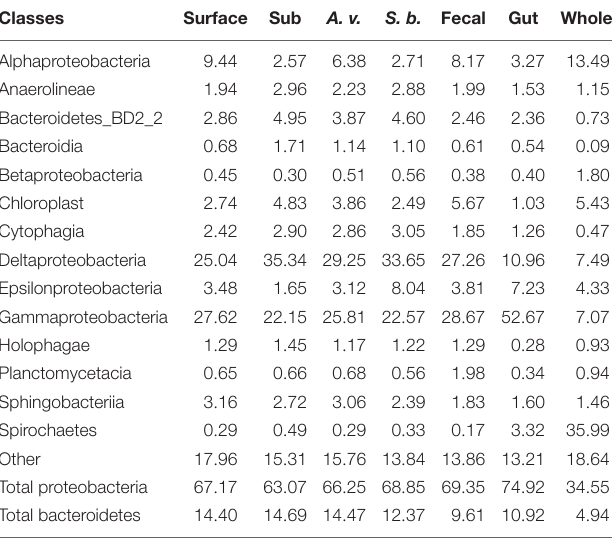
TABLE 1 | Major classes as a percentage of surface, sub-surface (Sub), Alitta virens burrows ( A . v .), Saccoglossus bromophenolosus burrows ( S . b .), S. bromophenolosus fecal castings (Fecal), S. bromophenolosus gut contents (gut), and sediment-free whole S. bromophenolosus (Whole) microbial communities; data are means for each sample type.